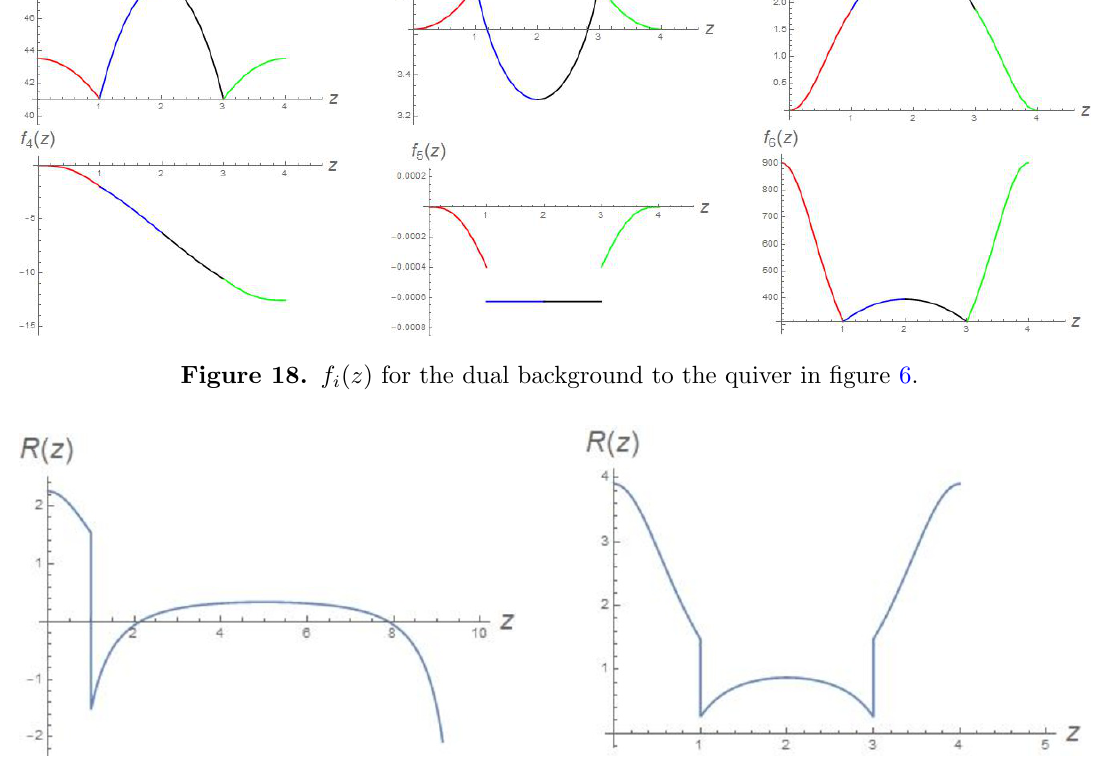
Figure 19. The Ricci scalars for the backgrounds associated to the quivers in (cid:12)gures 5 and 6